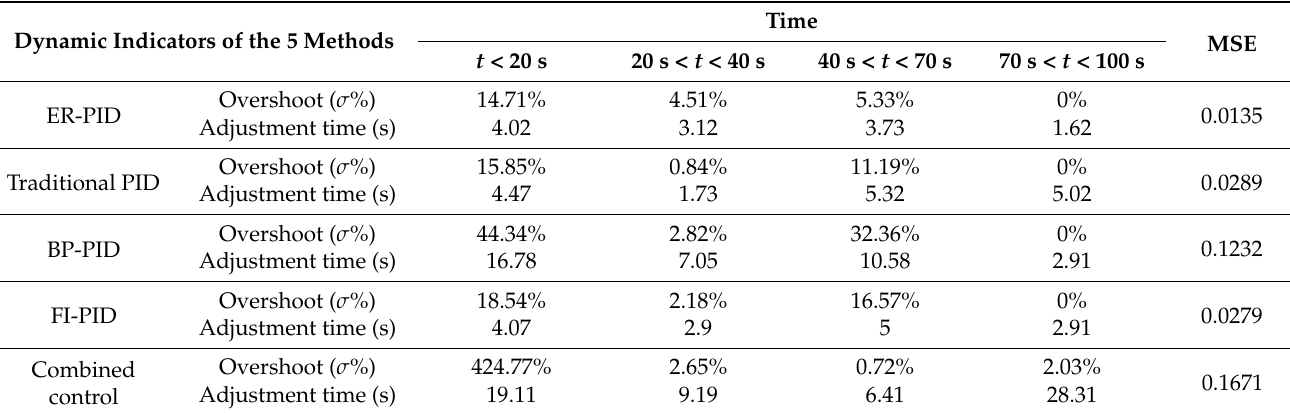
Figure 12. Changes of the control signal and controller parameters in multi-point perturbation situations. ( a ) Changes of the commanded motor torque Q c . ( b ) Changes of K P , K I , and K D .